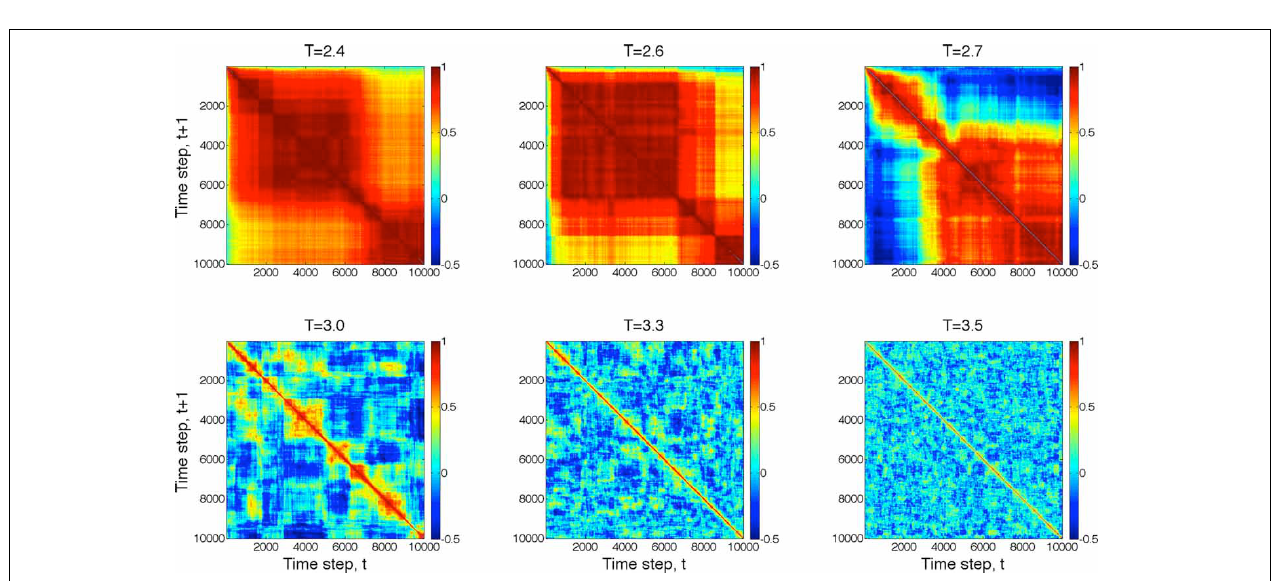
FIGURE 5 | Temporal correlation of global state patterns at successive time points and different activation levels, T. Simulation consisted of 10,000 time steps. Pseudo-color indicates the correlation coefficient, cc, of